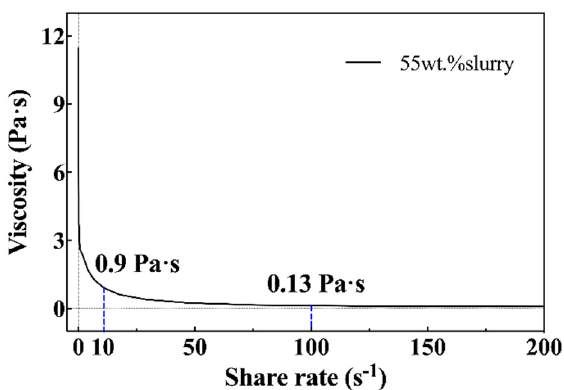
Figure 5. Shear viscosity ( η ) of ZrO 2 slurry with respect to the shear rate in the range of [0, 200] (s − 1 ).